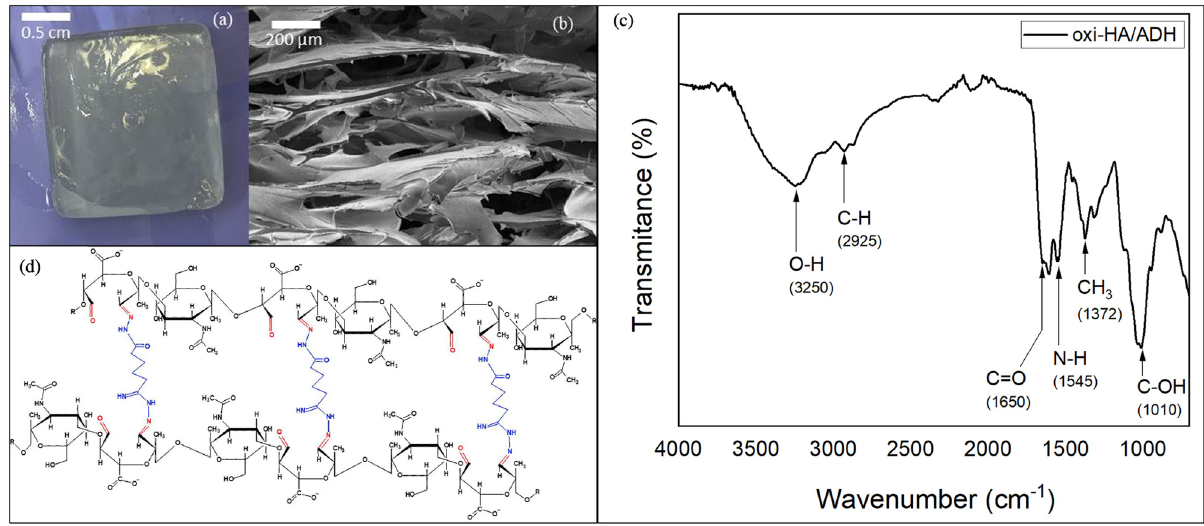
Figure 1: oxi - HA/ADH hydrogel: ( a ) macroscopic image, ( b ) surface scanning electron microscopic image, ( c ) ATR - FTIR spectrum, and ( d ) chemical structure.